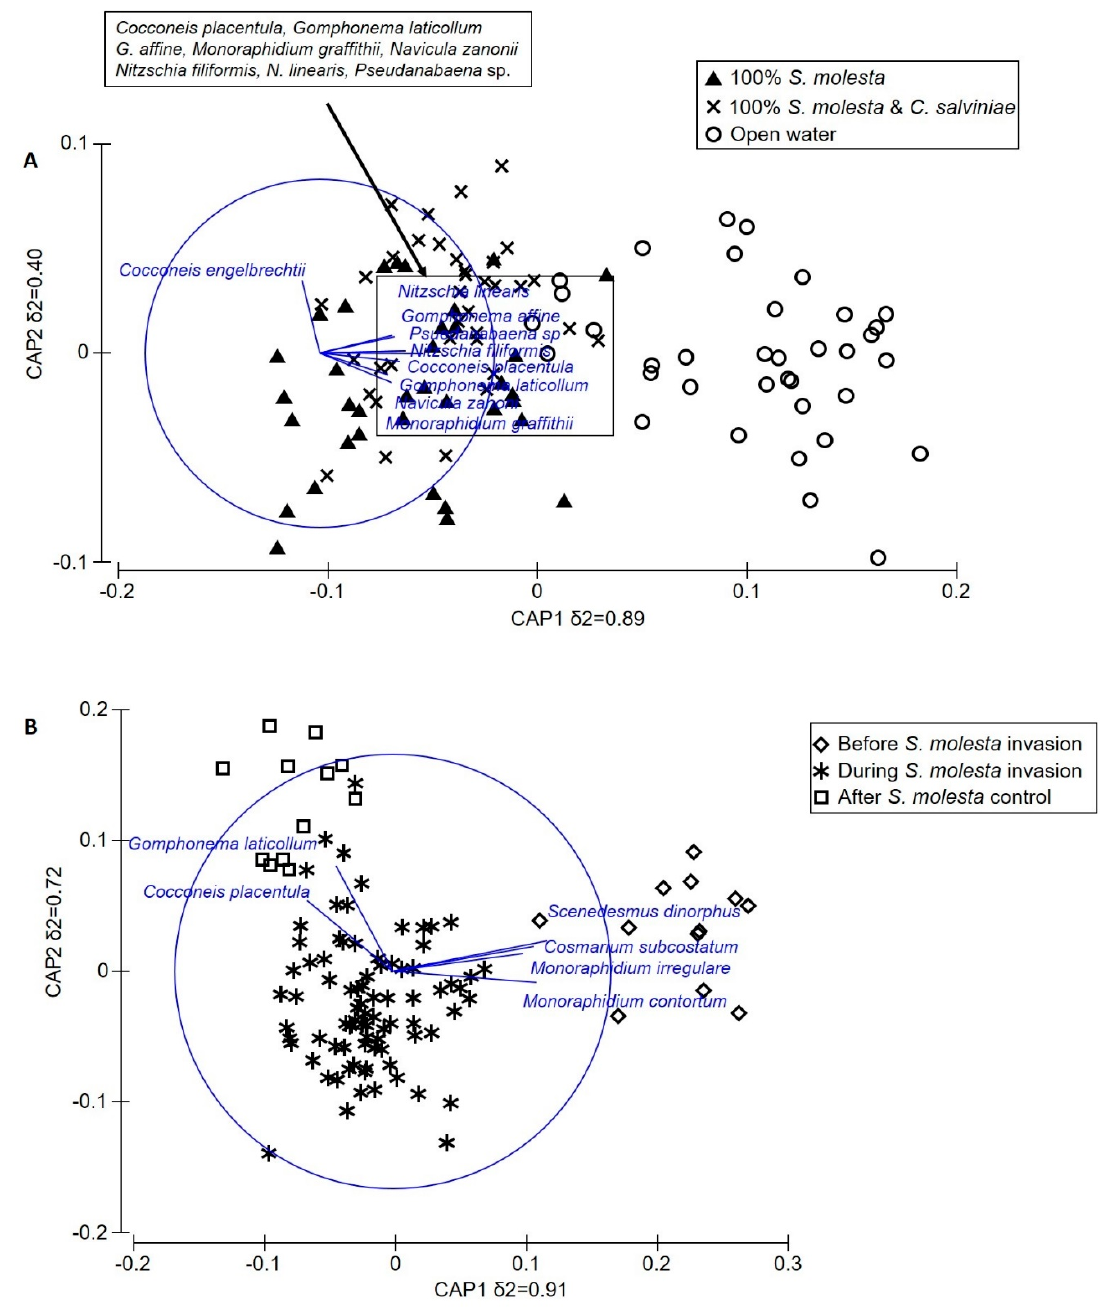
Figure 5. Canonical analysis of principal coordinate (CAP) ordination bi-plot indicating differences in epilithic algae assemblages found between treatments ( A ) and invasion phases ( B ) over 10 six-weekly sampling occasions. CAP δ 2 = indicating canonical correlation which is the percentage of explained assemblage variation per axis. Dominant taxa mean and standard deviation per treatment and invasion phases are presented in Table S2.